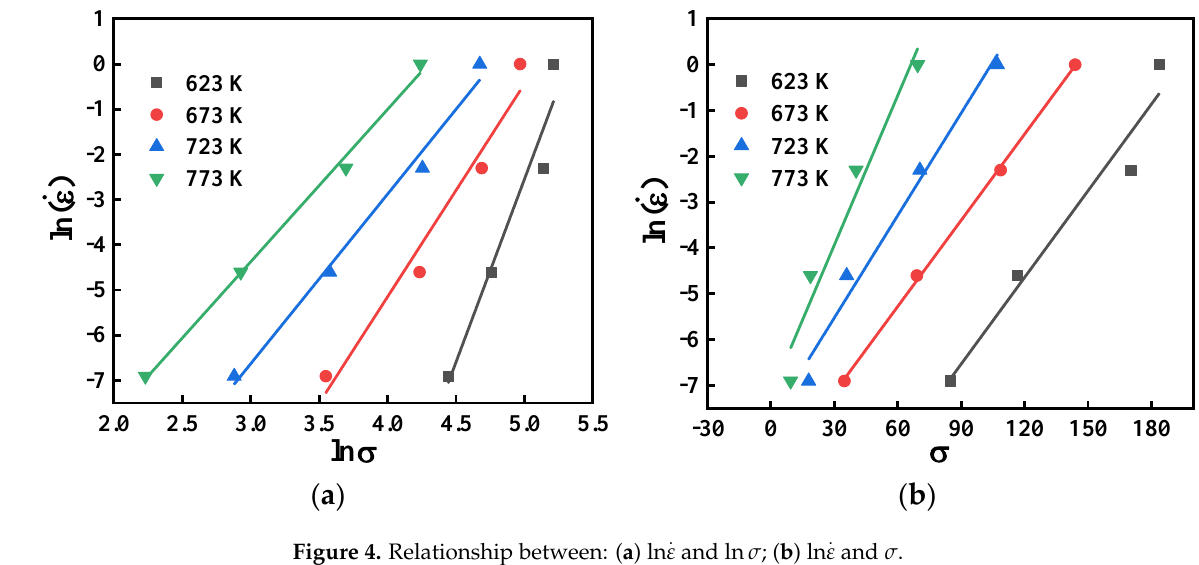
Figure 4. Relationship between: ( a ) ln 𝜀̇ and ln𝜎 ; ( b ) ln 𝜀̇ and 𝜎 .